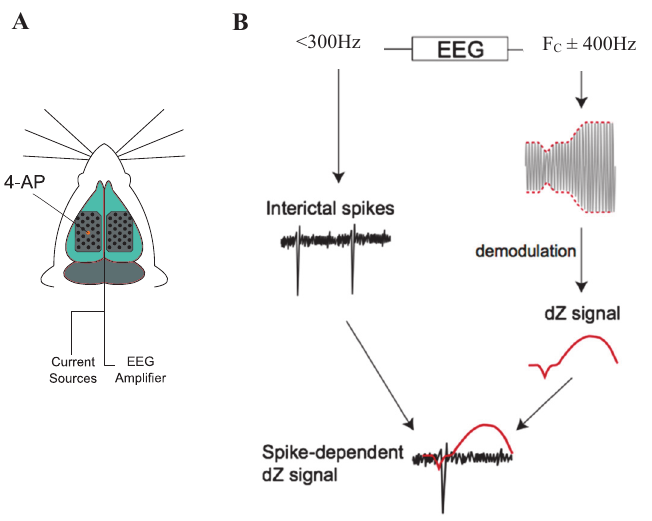
Fig. 6: (A) Experimental Setup. 60 electrodes were placed on either side of the brain. Seizures were triggered using a 4-AP Model. (B) Data extraction. By low pass (EEG) and bandpass (EIT) filtering, the data was split into the EEG component and the EIT component, from which the impedance change was extracted.